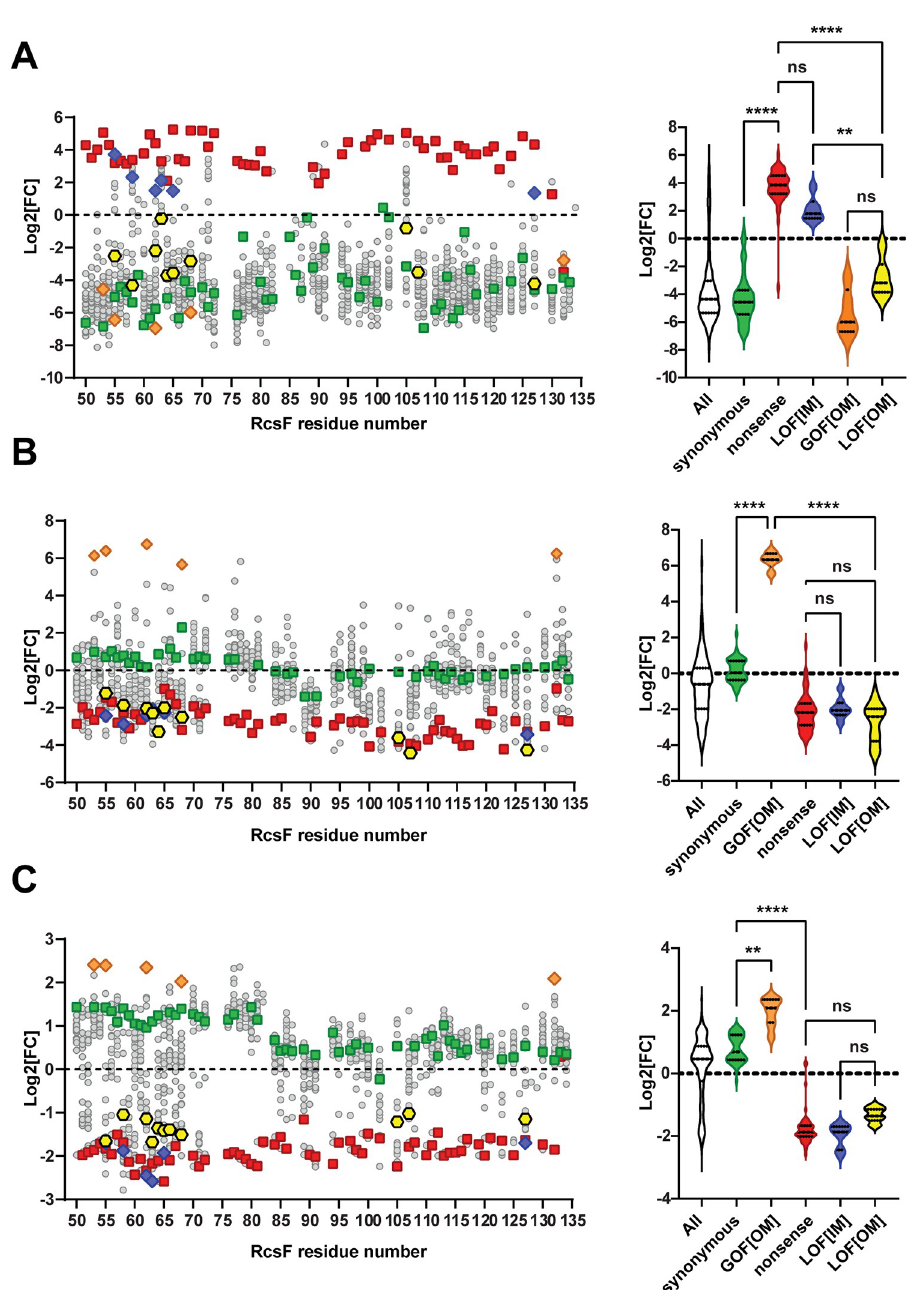
Fig 2. Genetic screens to isolate rcsF signaling mutants. ( A ). LOF[IM] screen based on LolB depletion. ( B ) GOF [OM] screen based on the growth on lactose versus glucose (11 generations of outgrowth). ( C ) LOF[OM] screen based on growth on lactose versus glucose (6 generations of outgrowth). Left panels: Log2[FC] of individual RcsF variants plotted against RcsF residue number. Nonsense variants (red), synonymous variants (green), and mutant variants characterized in detail are highlighted as follows: LOF[IM] mutants as blue diamonds, GOF[OM] mutants as orange diamonds, LOF[OM] mutants as yellow hexagons. Right panels: violin plots of log2[FC] distribution within RcsF variant groups. Lines represent the median and the two quartiles. Statistical analysis was performed using one-way ANOVA (multiple comparisons). n.s. = p � 0.05, �� = p < 0.01, ���� = p < 0.0001. Complete data for all detected RcsF variants are presented in S1